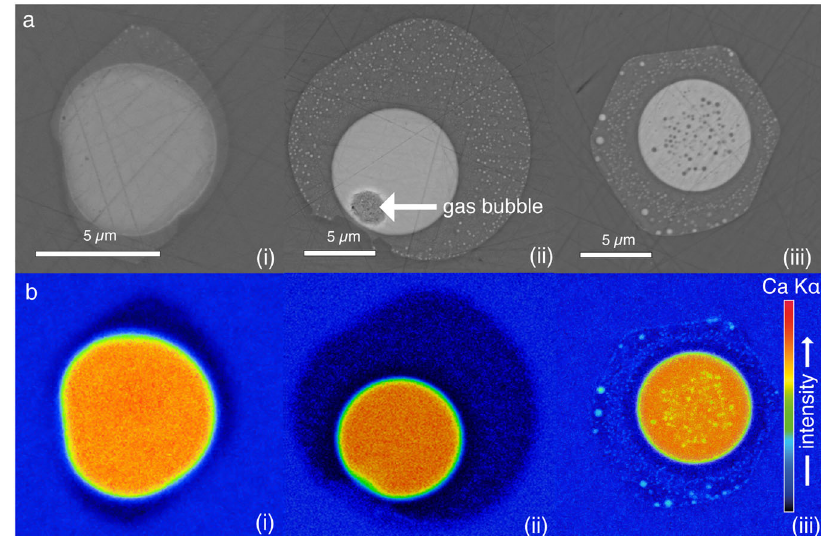
Fig. 1 | Back scattered electron images of selected melt inclusions. BSE ( a ) and X-ray intensity maps of Ca K α ( b ) of three exemplary melt inclusions. Melt inclu- sions(i)and (ii)containnosilicatemeltdroplets(Ls)intheimmisciblecarbonatite